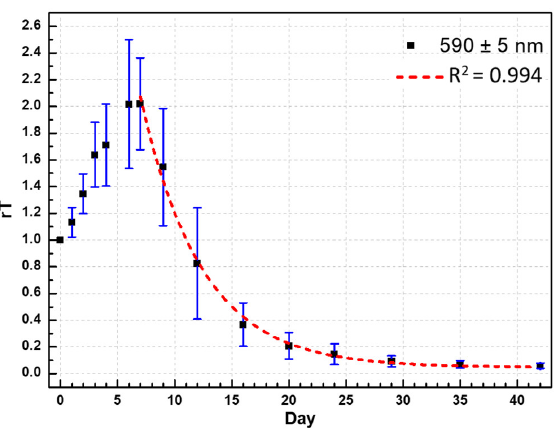
Figure 6. Relative transmittance (relative to the zeroth day), rT, of the duck eggs in the 590 ± 5 nm